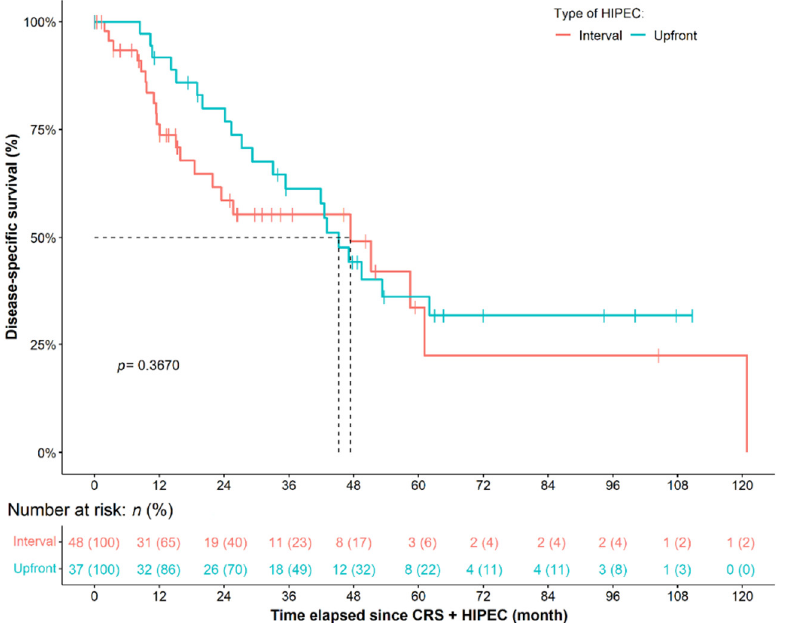
Figure 1. Primary ovarian cancer patients, who needed neoadjuvant chemotherapy (NACT) prior to CRS + HIPEC (interval HIPEC) had seemingly worse disease-specific survival compared to those who did not need NACT (upfront HIPEC). However, no statistical difference could be justified due to the change seen in the survival curve of interval HIPEC patients within the middle of the observation period. CRS: cytoreductive surgery; HIPEC: hyperthermic intraperitoneal